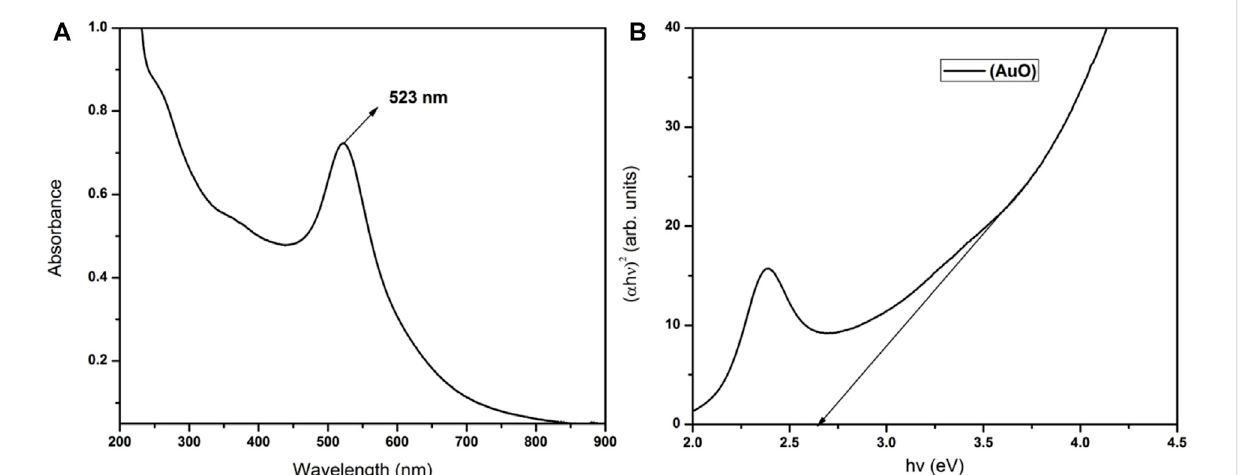
FIGURE 3 UV-visible analysis with (A) absorption spectra of AuNPs showing an optical absorption peak at λ max 523 nm and (B) total optical absorption band width ofreduced nanogoldobtained usingtheTauc plotshowing thecorresponding band gapenergy at2.68 eV,attributedto therelativesize of AuNPs.